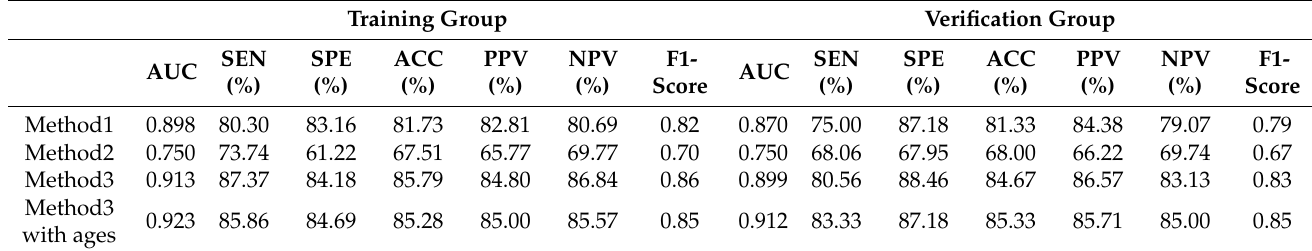
Table 3. Diagnostic performances of